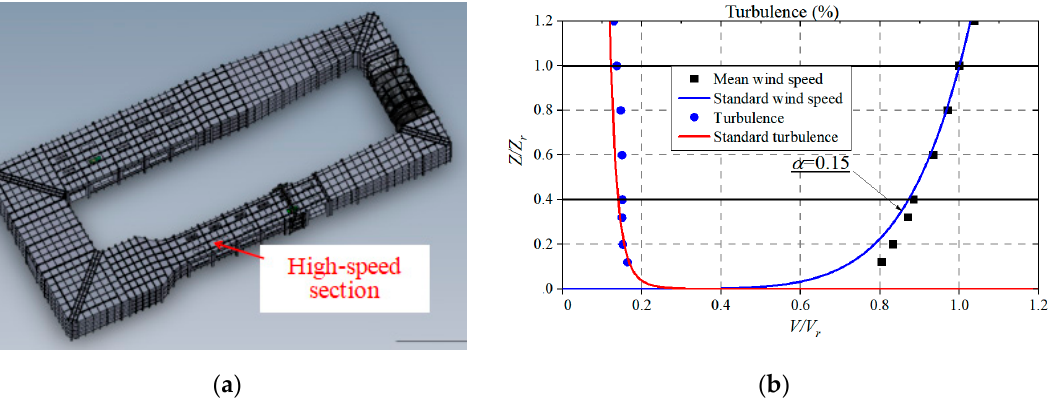
Figure 8. Wind tunnel and wind filed profile. ( a ) Closed-circuit wind tunnel in Beijing Jiaotong University. ( b ) Mean wind speed and turbulence intensity profiles.